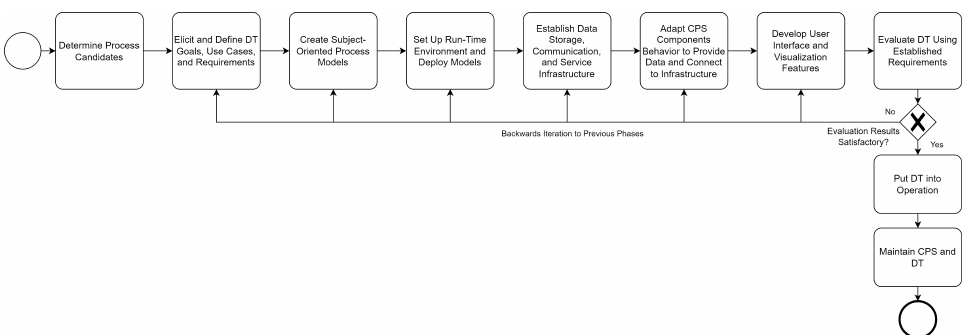
Figure 10. Generic steps for realizing the proposed digital twin